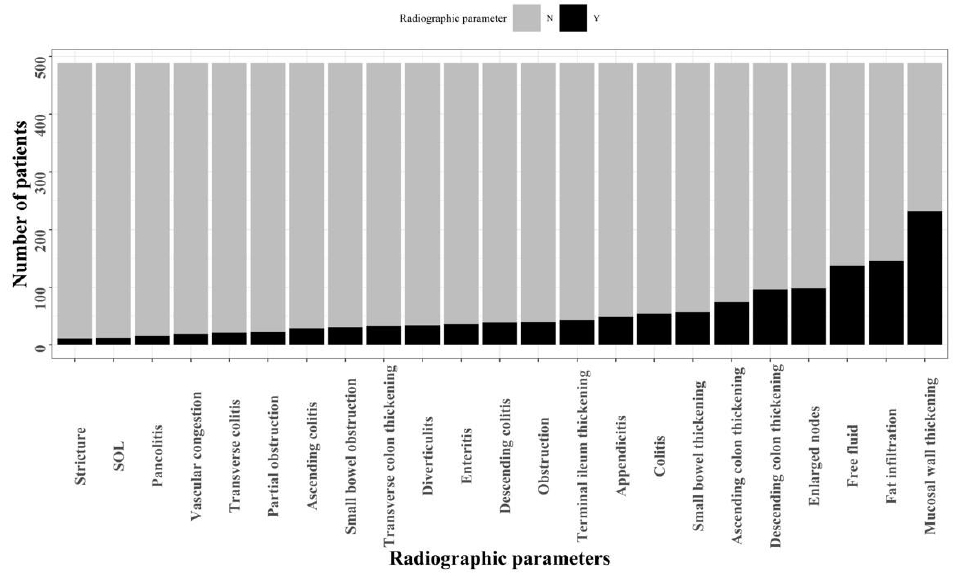
Figure 2. Frequency of radiographic parameters as assessed by abdominal CT (SOL — space-occu- pying lesion).